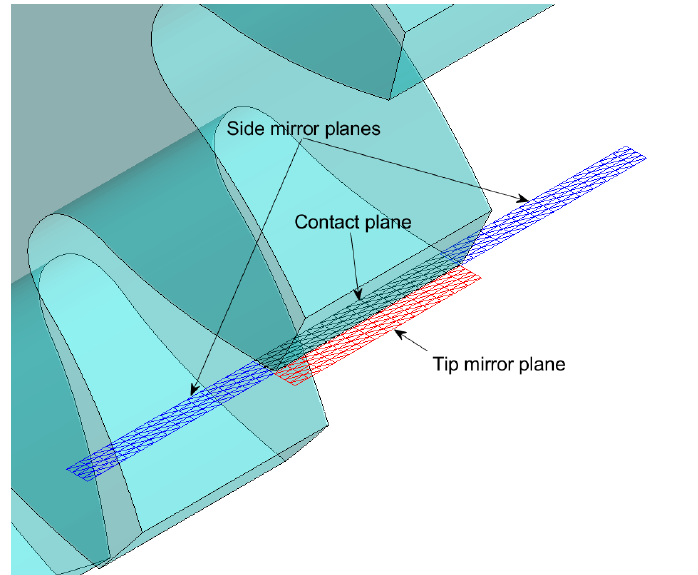
Figure 10. Side and tip mirror planes in gear contact used to obtain the mirror pressure distributions in order to take into account the free edges of the contacting